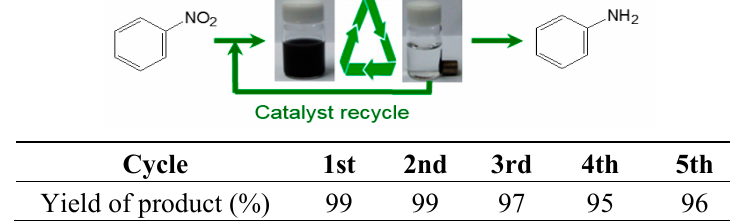
Table 5. Magnetic separation and recycling of the magnetically-recyclable hollow nanostructured Rh catalyst in the heterogeneous reduction of nitrobenzene with hydrazine under the optimized reaction conditions. Reprinted with permission from